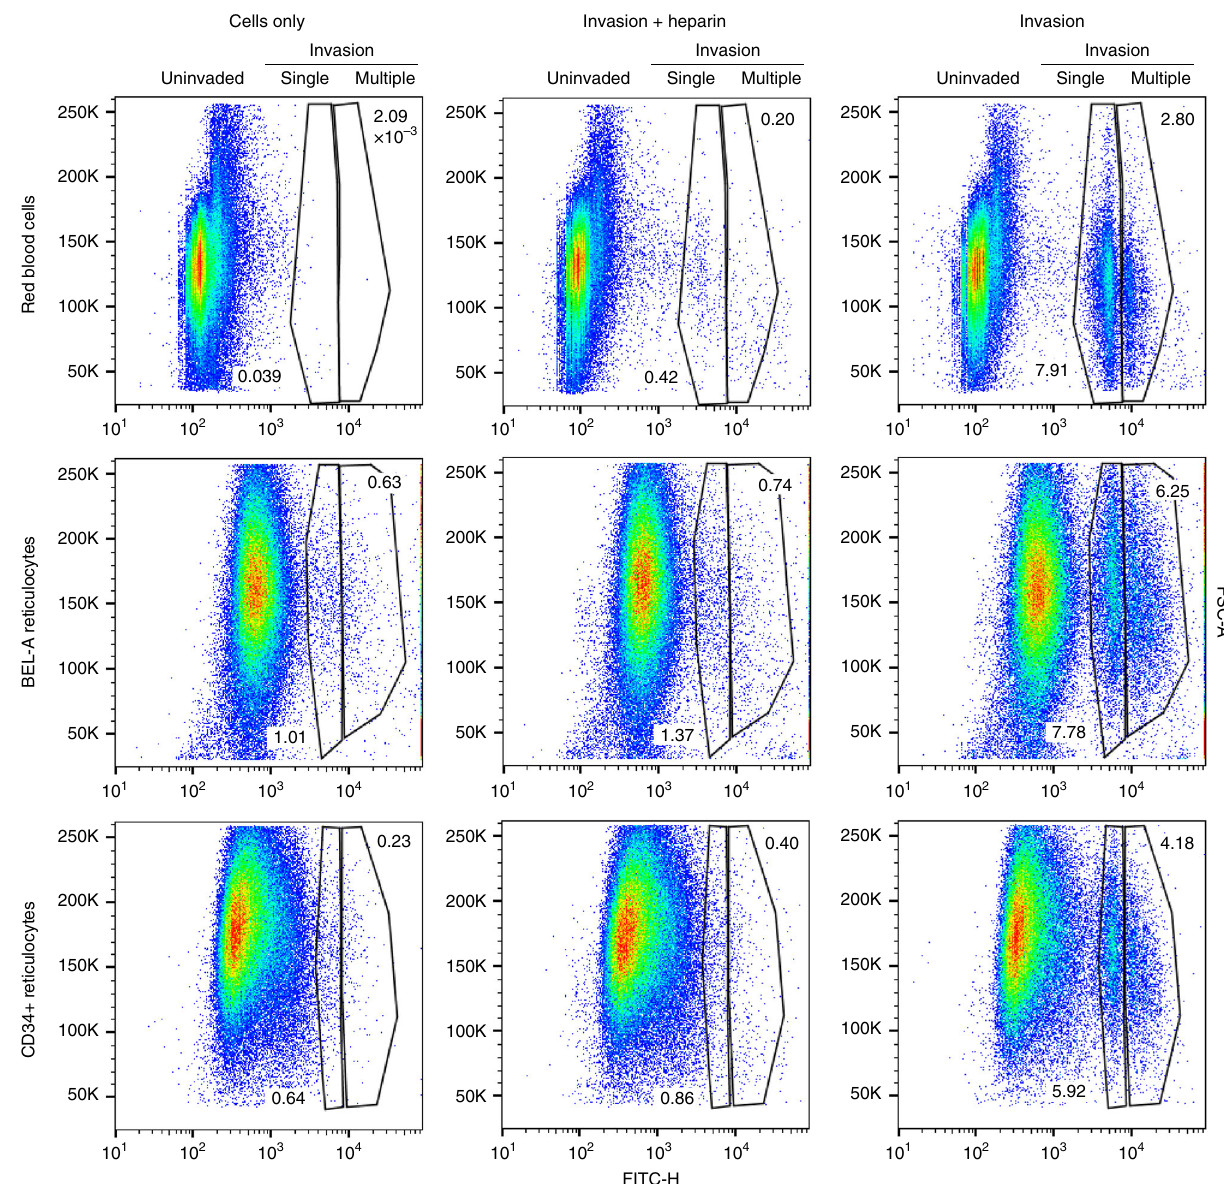
Fig. 2 Flow cytometry can be used to quantify invasion in BEL-A-derived reticulocytes. Flow cytometry dot plots illustrate ability to quantify invasion using fl ow cytometry by identi fi cation of uninvaded, singly, and multiply-invaded populations of red blood cells, BEL-A, or CD34 + cell-derived reticulocytes based on SYBR Green labeling intensity. Source data are provided as a Source Data fi le